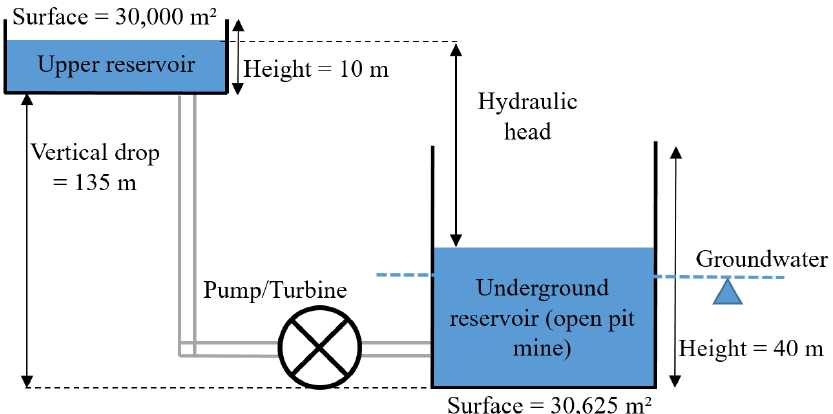
Figure 1. Topology of the modeled PSH unit on Maizeret site [21].